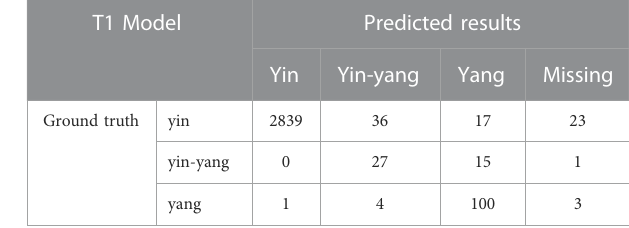
TABLE 2 Segmentation performance of four Mask R-CNN models (IoU threshold = 0.5).